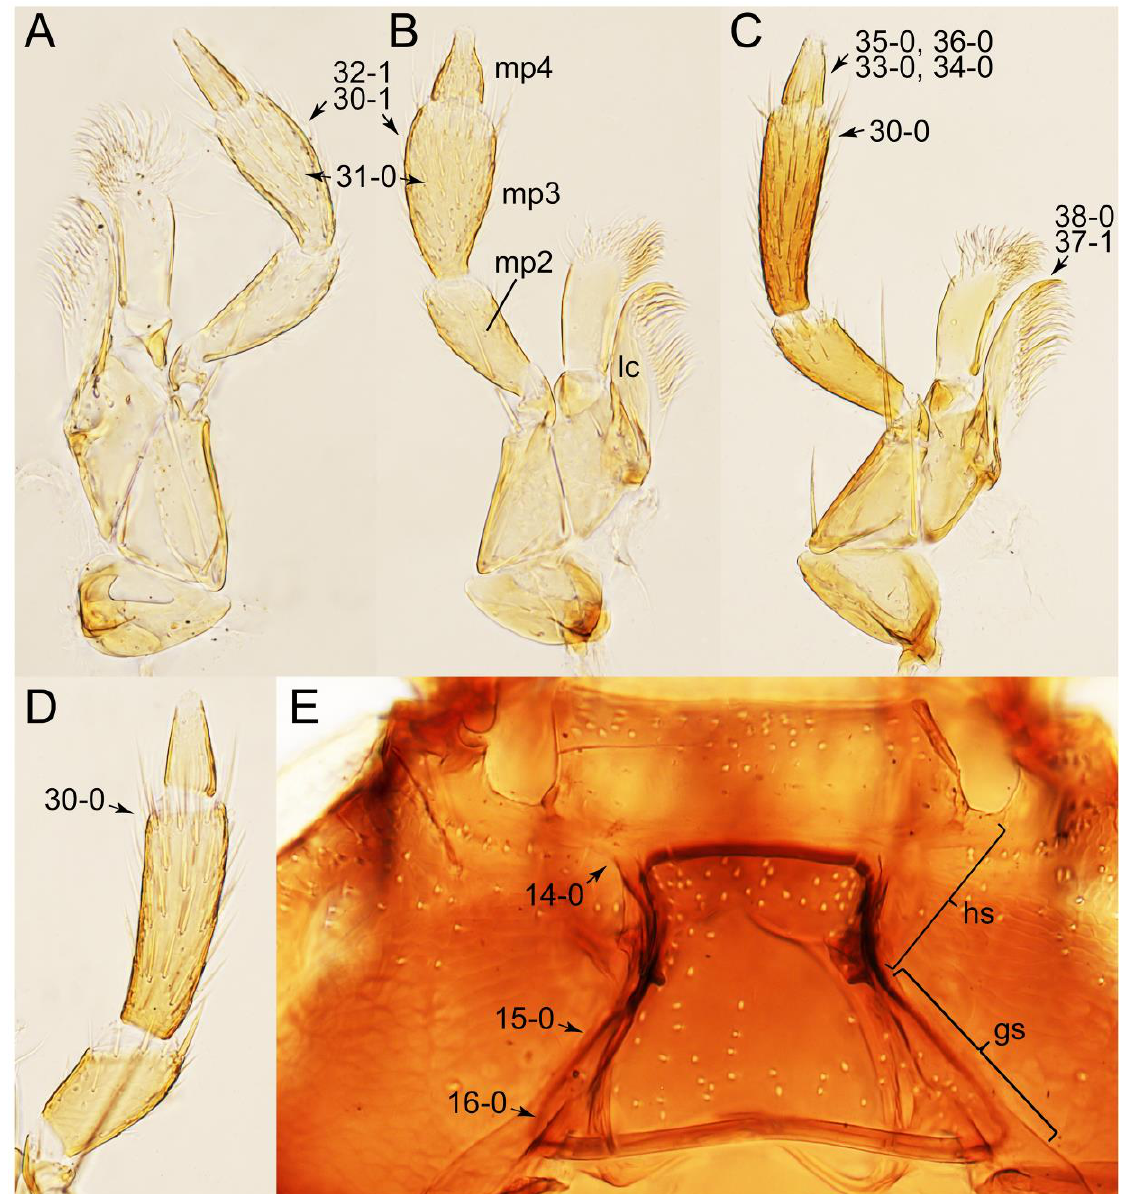
Figure 10. Photographs of body parts of Tachyporini: Tachyporina, enlarged. ( A ) left maxilla of Tachyporus jocosus , ventral view. ( B ) right maxilla of Palporus nitidulus , ventral view. ( C ) right maxilla of Lamprinodes saginatus , ventral view. ( D ) left maxilla of Lamprinus erythropterus , ventral view. ( E ) hypostomal and gular sutures of Tachyporus jocosus , ventral view. Abbreviations: gs, gular suture; hs, hypostomal suture; lc, lacinia; mp2–4, maxillary palpomere 2–4. Characters and character states (format X-X) are indicated on each